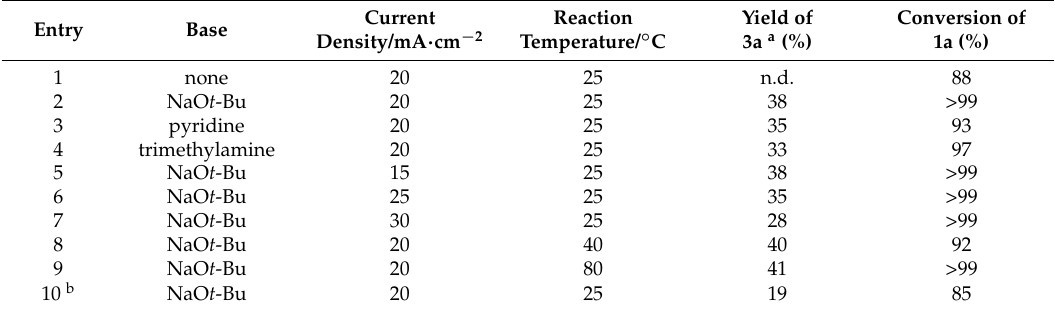
Table 2. Cathodic cross-coupling reaction of 4-iodotoluene ( 1a ) with benzonitrile ( 2a ) in various reaction conditions.